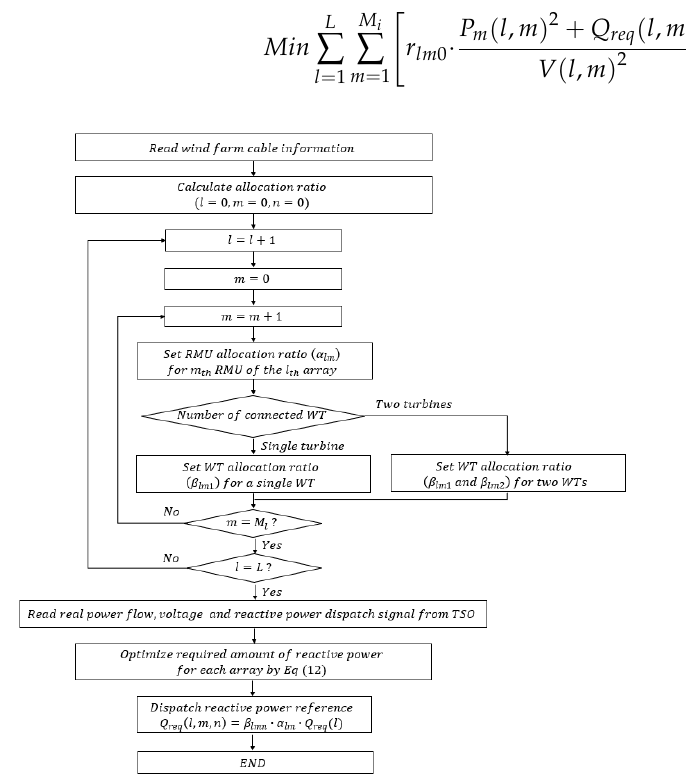
Figure 5. Flow chart of the reactive power allocation algorithm for the Dongbok wind farm.